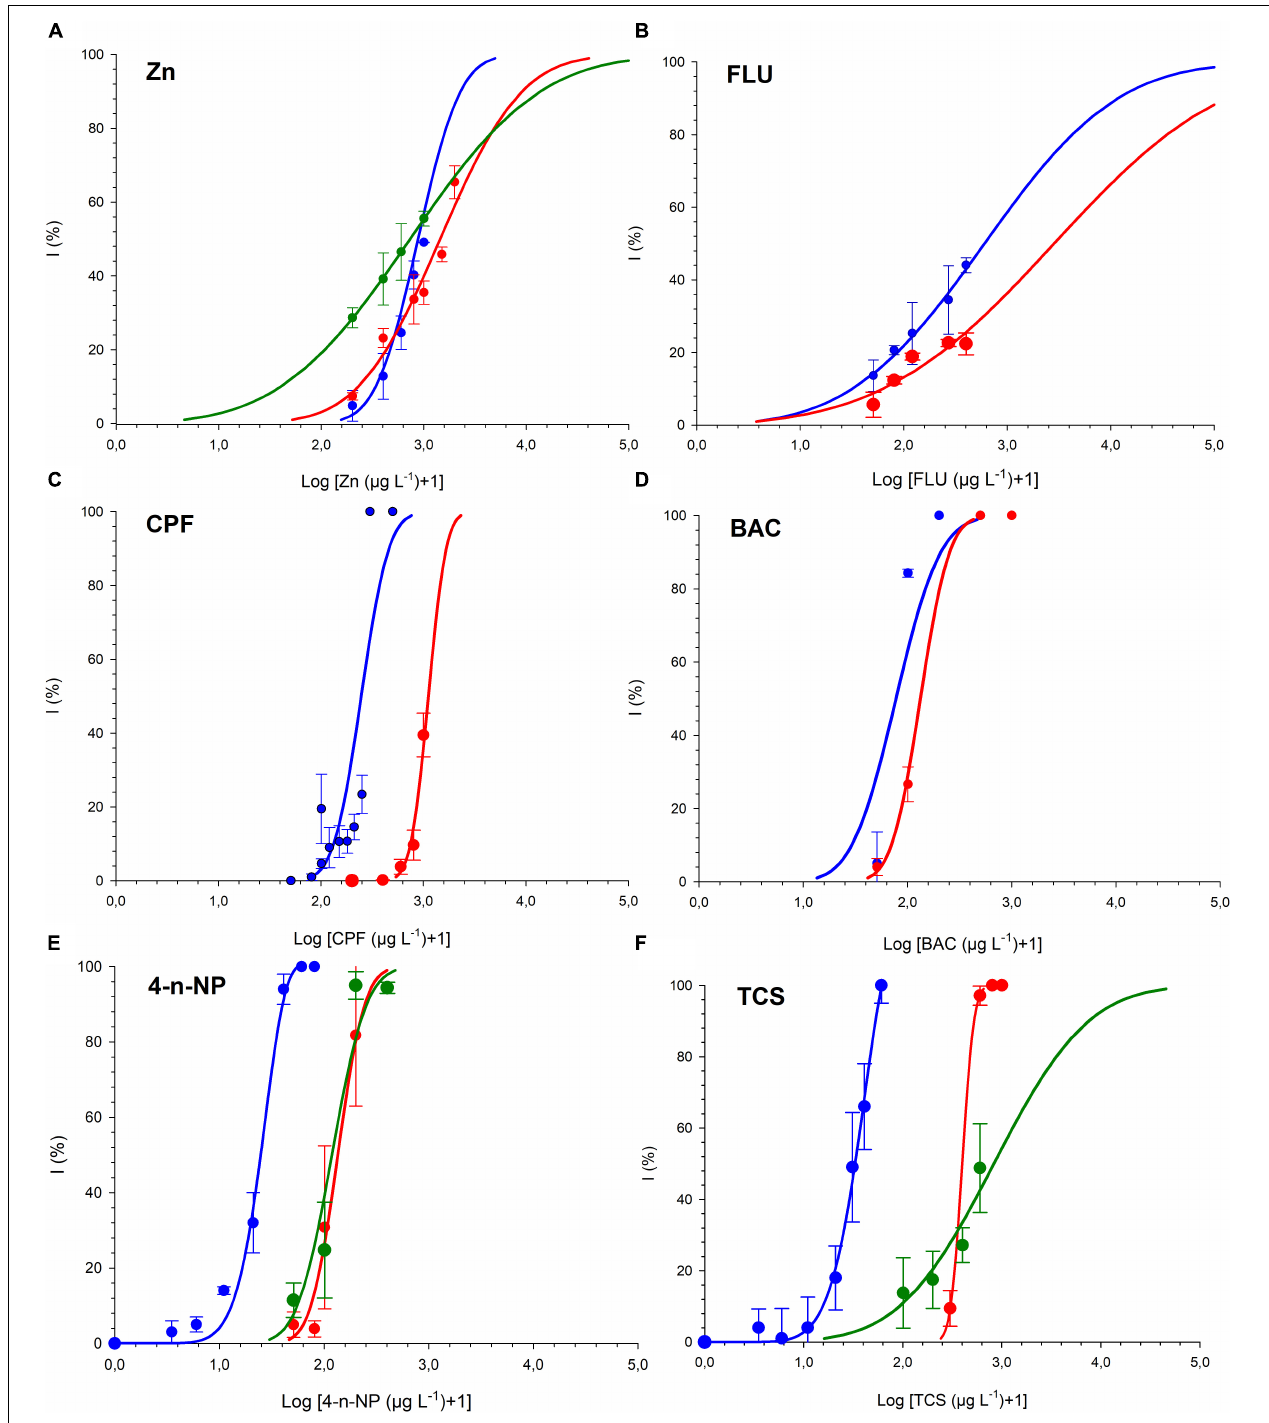
FIGURE 1 | Growth inhibition of T-iso (blue), P. tricornutum (red) and R. subcapitata (green) exposed to (A) Zinc (B) Fluoranthene (C) Chlorpyrifos (D) Benzalkonium chloride (E) 4-n-Nonylphenol. (F) Triclosan. Blue curve from panel (E,F) published in Tato et al. (2018).